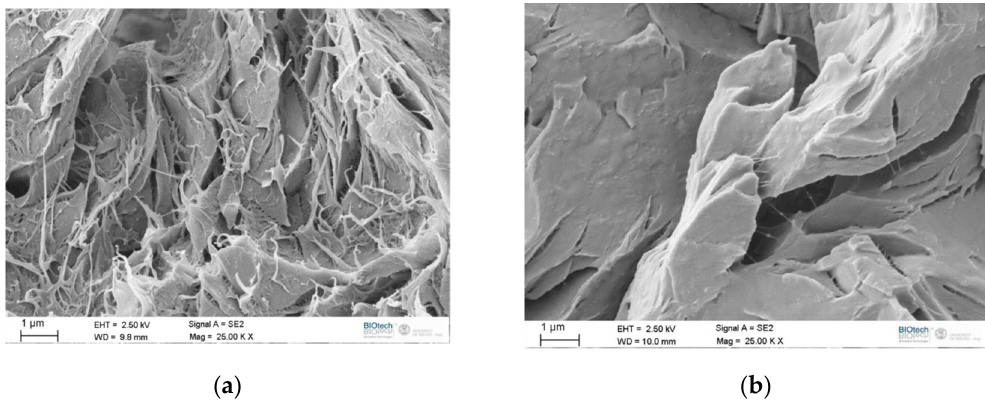
Figure 9. SEM micrographs of fracture surface of EP-PCL samples before the healing. ( a ) Quasi-static tests and ( b ) impact tests.